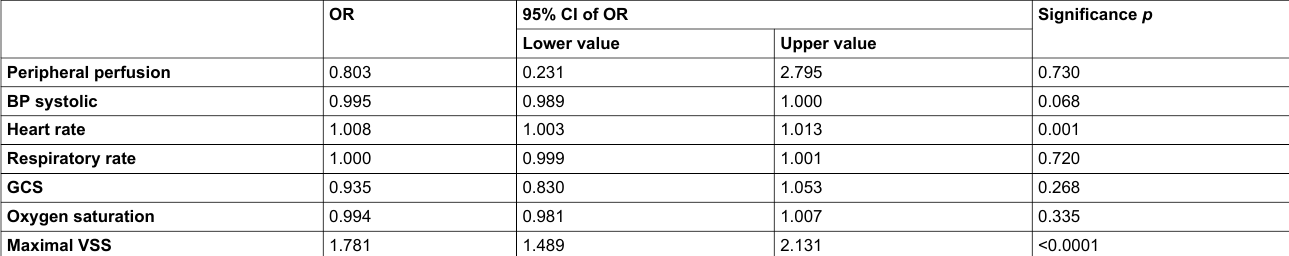
Table 5: Results of univariate logistic regression of single vital sign parameters occurring in the 24h before MET call in correlation to hospital